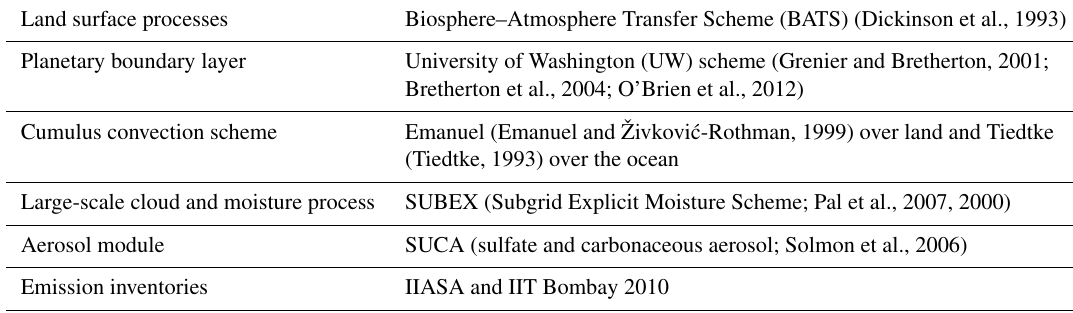
Table 1. The choice of parameterization schemes for the experiments carried out in this